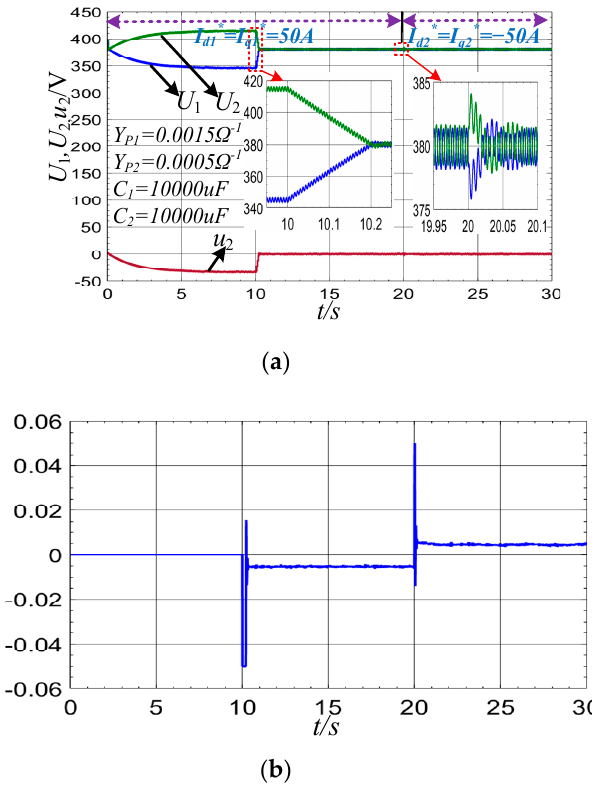
Figure 10. Waveforms when considering the polarity of I vd . ( a ) DC voltages. ( b ) The instruction value s 0 .